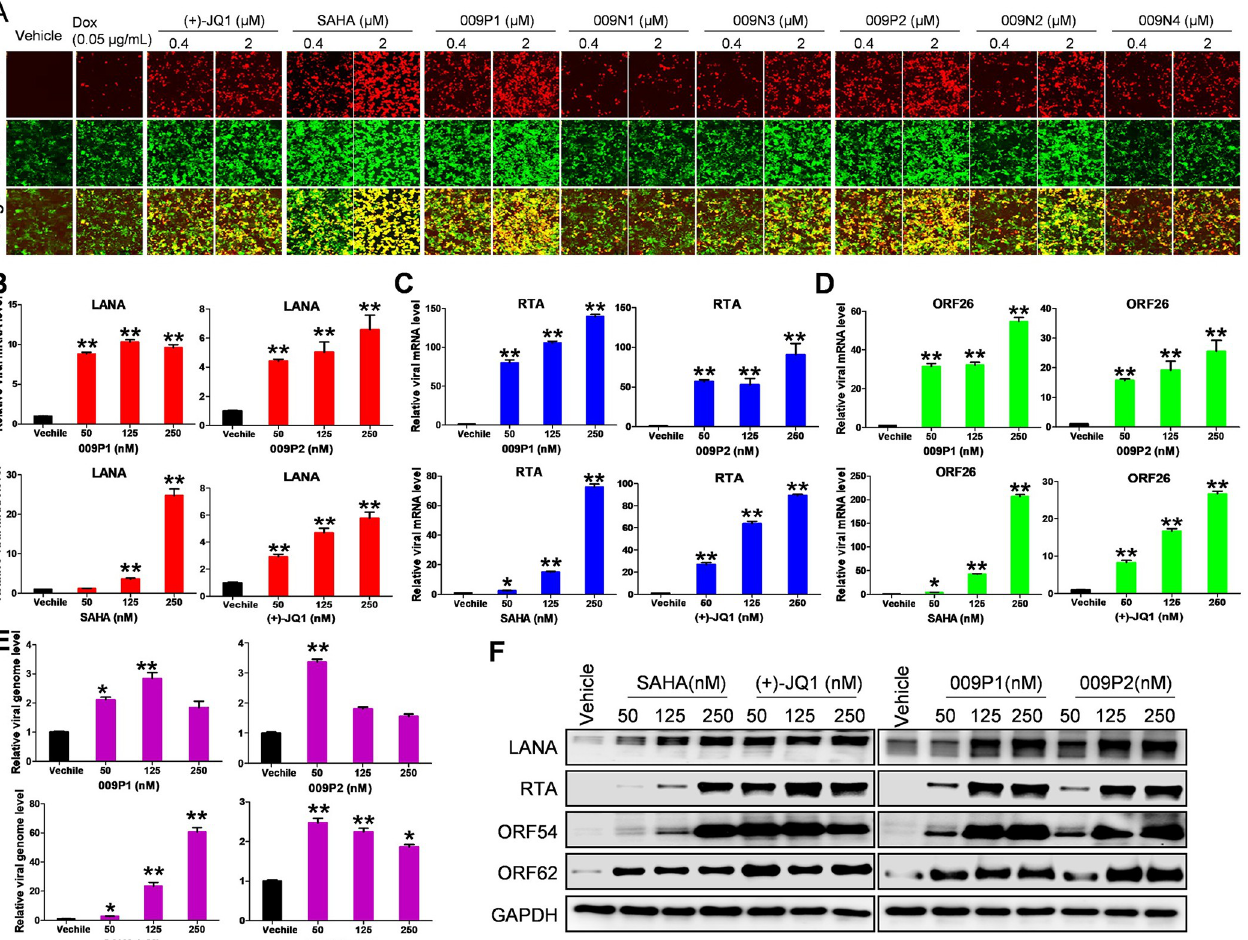
Fig 5. New dual inhibitors 009P1 and 009P2 treatments strongly induce KSHV lytic reactivation. ( A ) The iSLK.219 cells were treated by indicated concentrations of compounds in the addition to Dox (0.05 μ g/mL) for 24 h, then the fluorescence intensity was detected via microscopy. ( B-F ) The transcripts of viral genes, viral DNA levels and protein expression were measured by using RT-qPCR, qPCR, and Western blot, respectively. SAHA and (+)-JQ1 were used as positive control. Error bars represent S.D. for 3 independent experiments, �� = p < 0.01 (vs vehicle control).